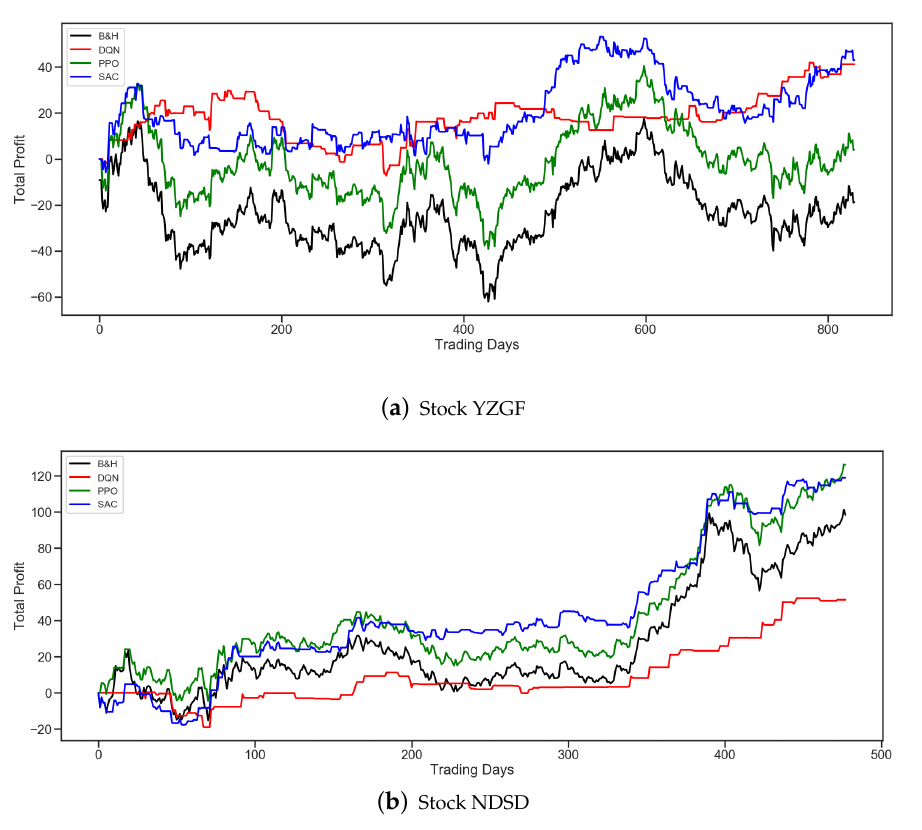
Figure 6. Profit curves of different trading methods on different